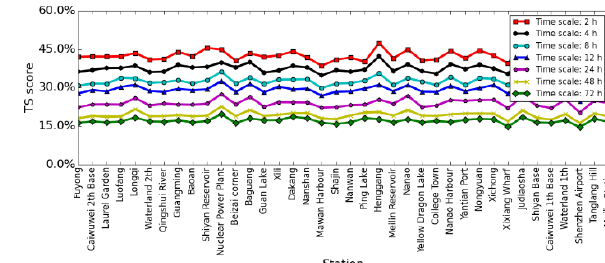
Figure 7.TS scores of different time scale SVM for future 2 hours precipitation